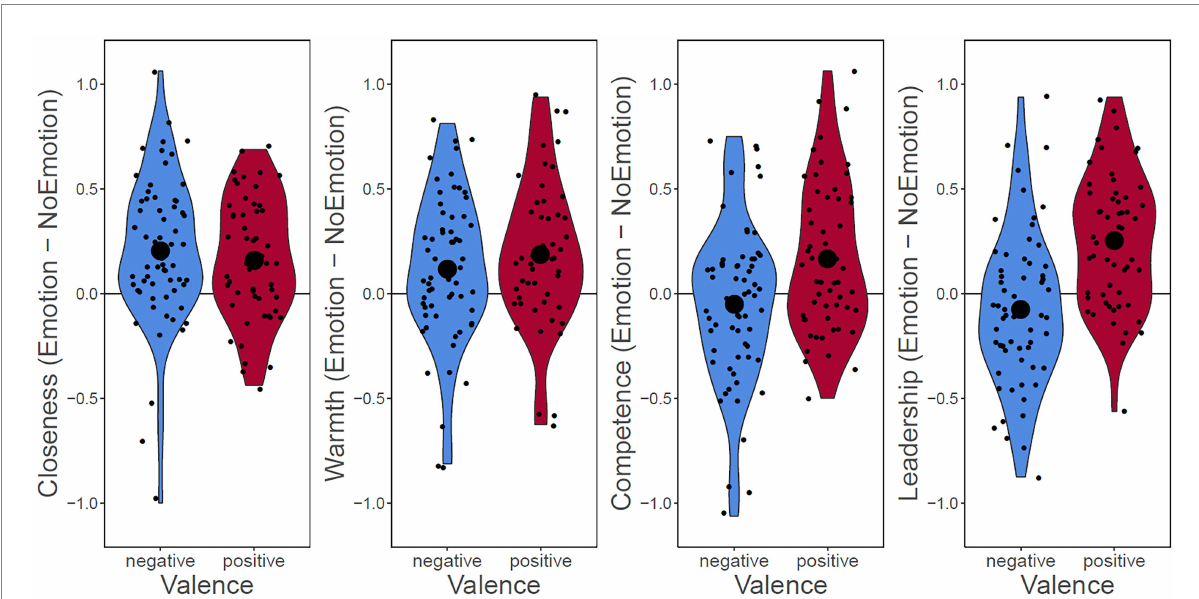
FIGURE 3 Violin Plots of Effects of Sharing Emotions on the Four Outcome Variables for (Red) Positive and (Blue) Negative Emotions. To create this figure, the difference between the Emotion and NoEmotion version of each sentence was calculated for each outcome variable. Then, an average difference score per participant and outcome variable was calculated across the 16 sentences. Each dot represents the result for one participant. The large dot represents the mean across participants. Figure serves visualization only, as the analysis was conducted using mixed-effects models on the trial-by-trial data. n = 119.